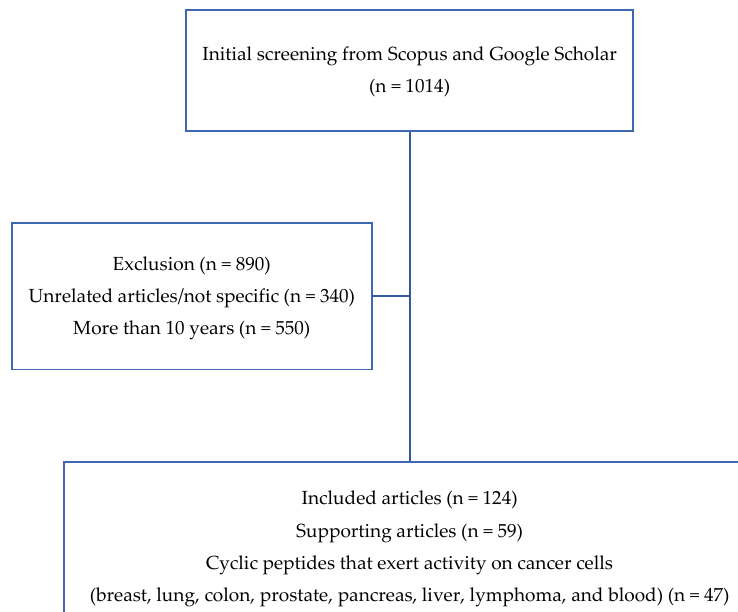
Figure 2. Literature search flowchart.